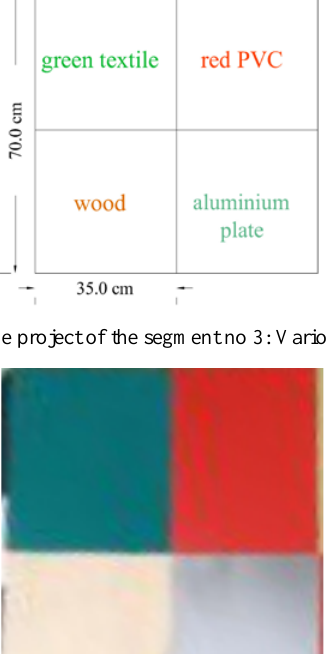
The second element used for assessment of spectral resolution is divided into four parts- two are painted with two different kinds of green paint and the next two with two kinds of red paint. Both red and green colours are almost indistinguishable with the naked eye or RGB sensor, but additional spectral channel, e.g. IR or narrower spectral channel, like in hyperspectral sensors would allow to distinguish different paints- Figure 8-9.